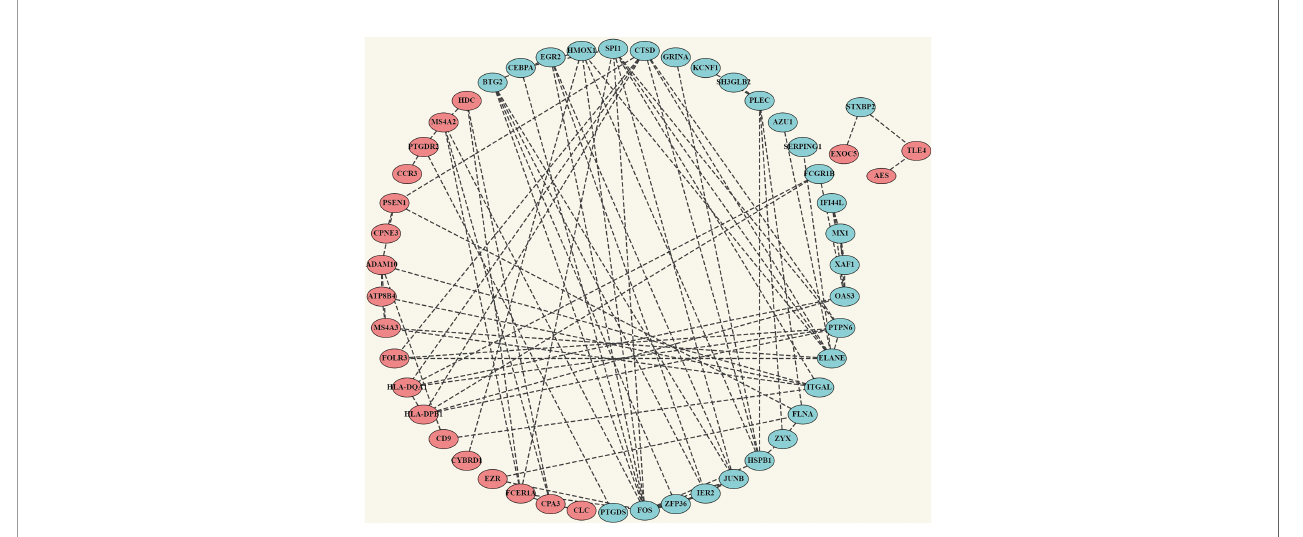
FIGURE 4 | Construction of PPI network. Complete PPI network diagram which contains 66 nodes and 91 edges with the con fi dence >0.4. Upregulated Robust DEGs are marked in red while Downregulated Robust DEGs are marked in blue. PPI, Protein – Protein Interaction